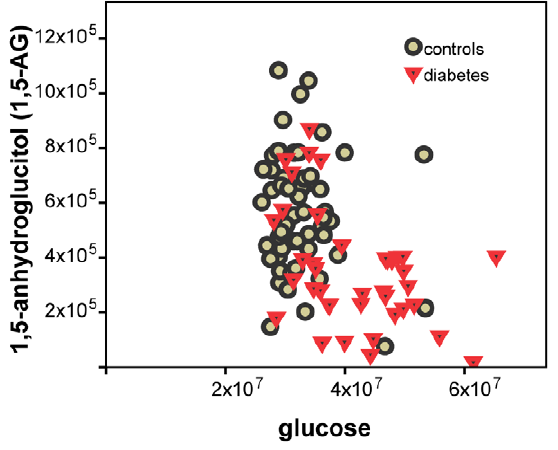
Figure 2. 1,5-AG and glucose (measured on Metabolon platform). Lower 1,5-AG concentrations at higher glucose levels in participants with diabetes when compared to the control group display the currentroleof1,5-AGasamarkerforglycemiccontrolinpatientswithdiabetes.